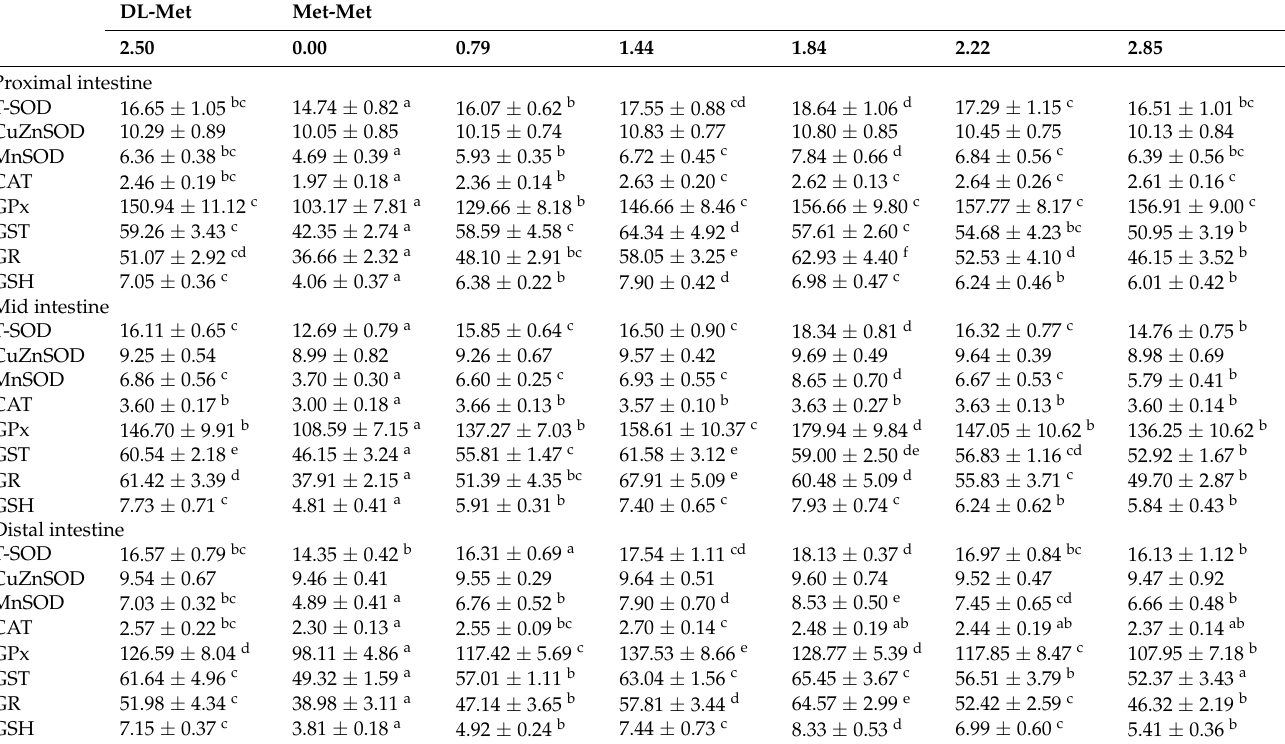
Table 3. Effects of dietary DL-Met and Met-Met supplementation (g/kg diet) on antioxidant-related parameters in three intestinal segments of juvenile grass